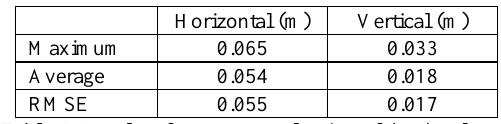
Table 4. Results of accuracy evaluation of the developed vehicle-loading